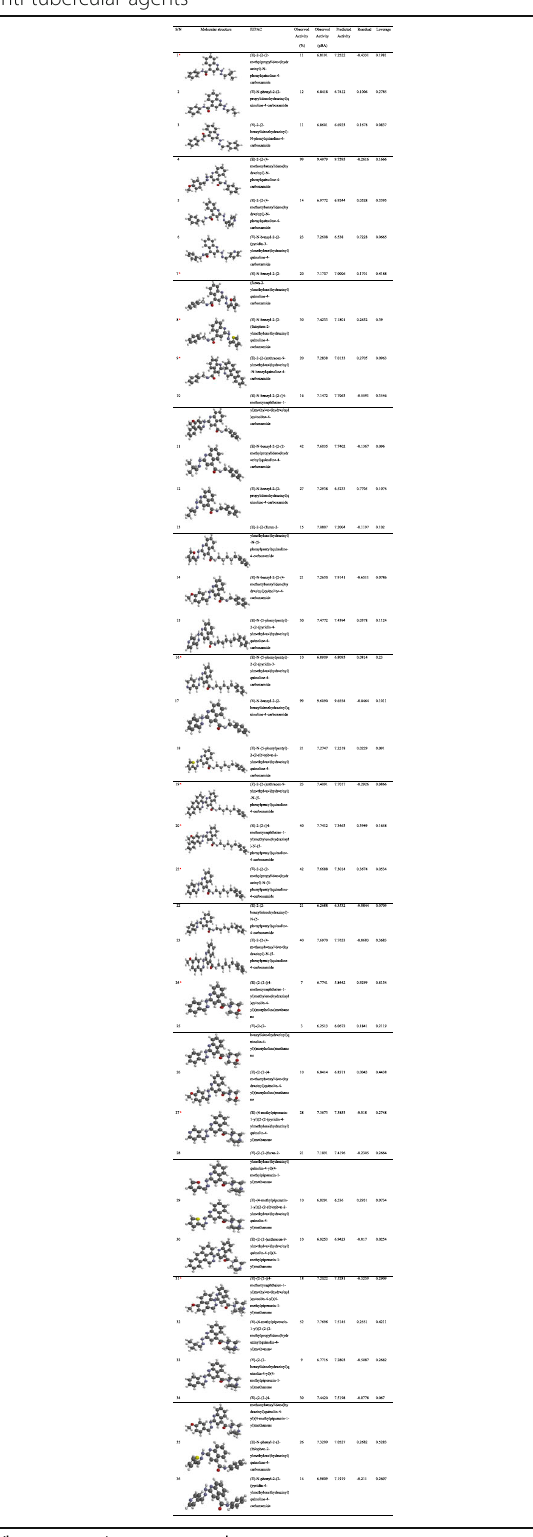
Table 1 Geometrical structures of inhibitory compounds